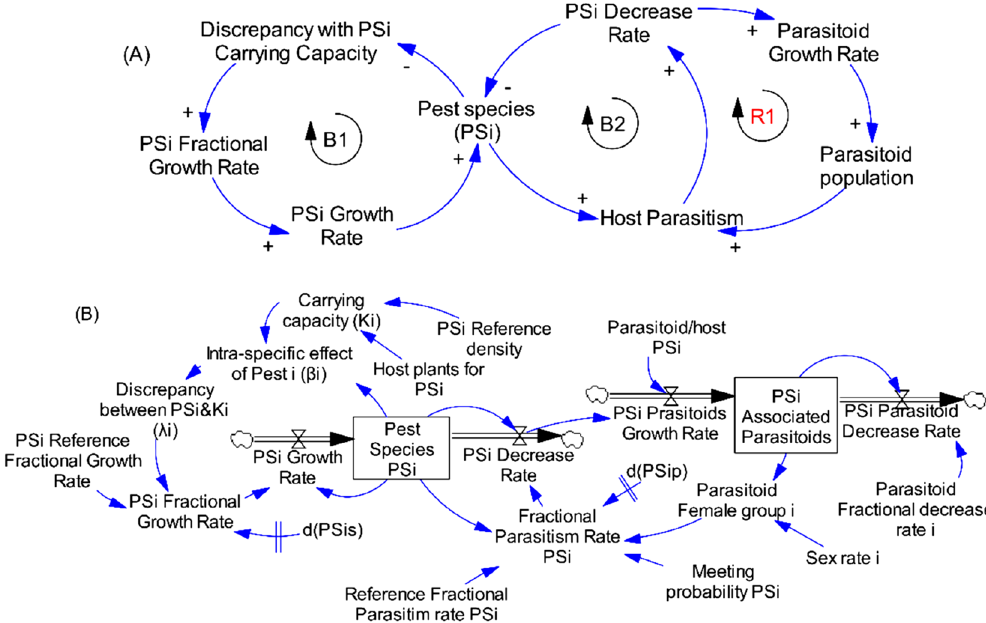
Figure 4. Causal loops ( A ) and flow diagram ( B ) of one pest species and its parasitoids and the resource in the